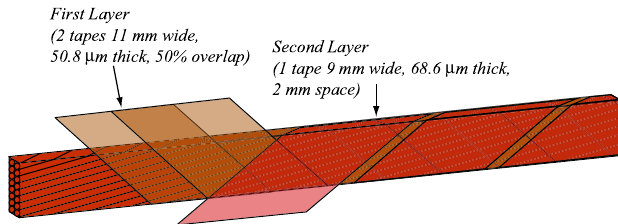
FIG. 1. (Color) State-of-the-art Nb-Ti insulation (LHC